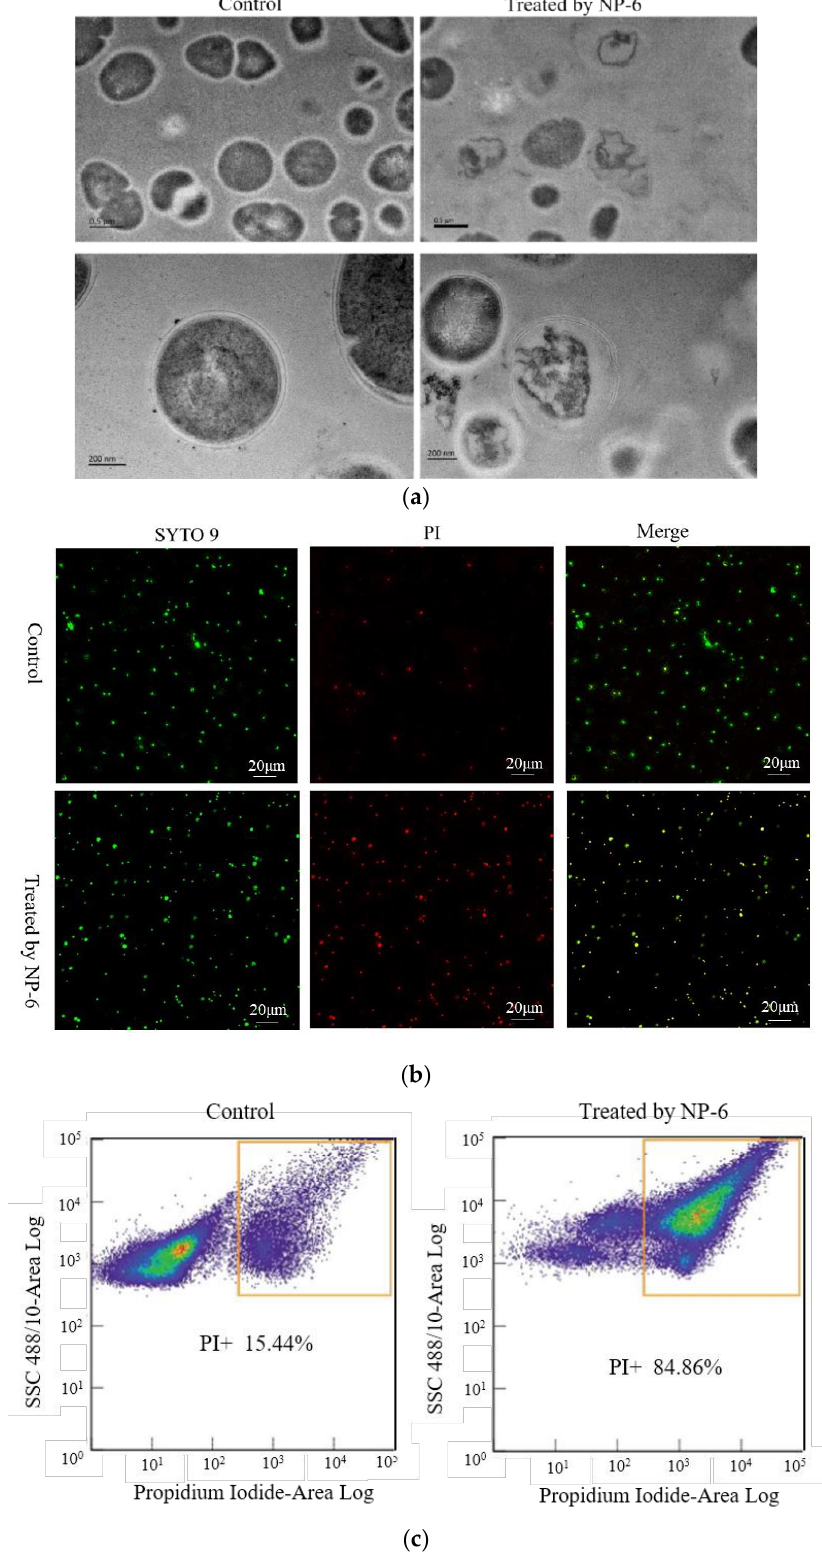
Figure 3. Effect of NP-6 on the cell membrane of S. aureus . ( a )Transmission electron micrographs; ( b ) confocal images; ( c ) flow cytometry analysis. The control was processed without NP-6. Note: In ( b ), green dots indicate cells are either alive or dead, red dots indicate dead cells, yellow dots indicate dead